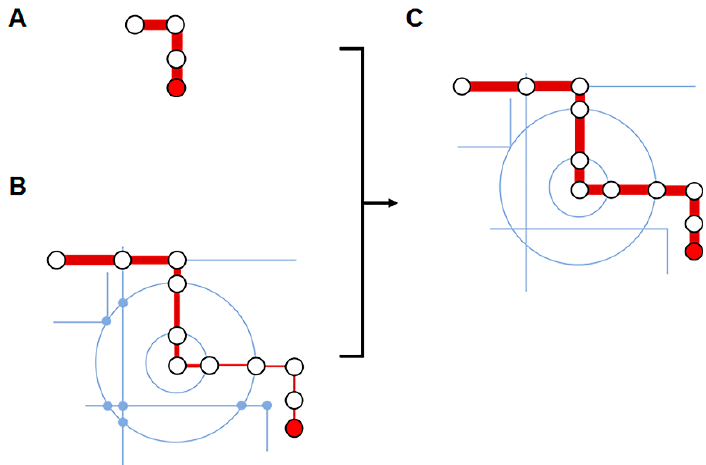
Figure 5. Cell-free metabolic engineering based on cell extract. ( A ) Enzyme-based cell-free metabolic engineering offers greater flexibility and controllability. However, the requirement for purified individual enzyme limits its use for multi-step bioconversion. ( B ) On the other hand, cell-based metabolic engineering suffers from the complexity of cellular metabolic pathways and the fluxes of intermediates can be reduced by their cellular consumptions (represented by gradual reduction of the thickness of red line). ( C ) Cell-free metabolic engineering can hitchhike the cellular metabolism, while minimizing genetic modification of host cells and loss of intermediates.